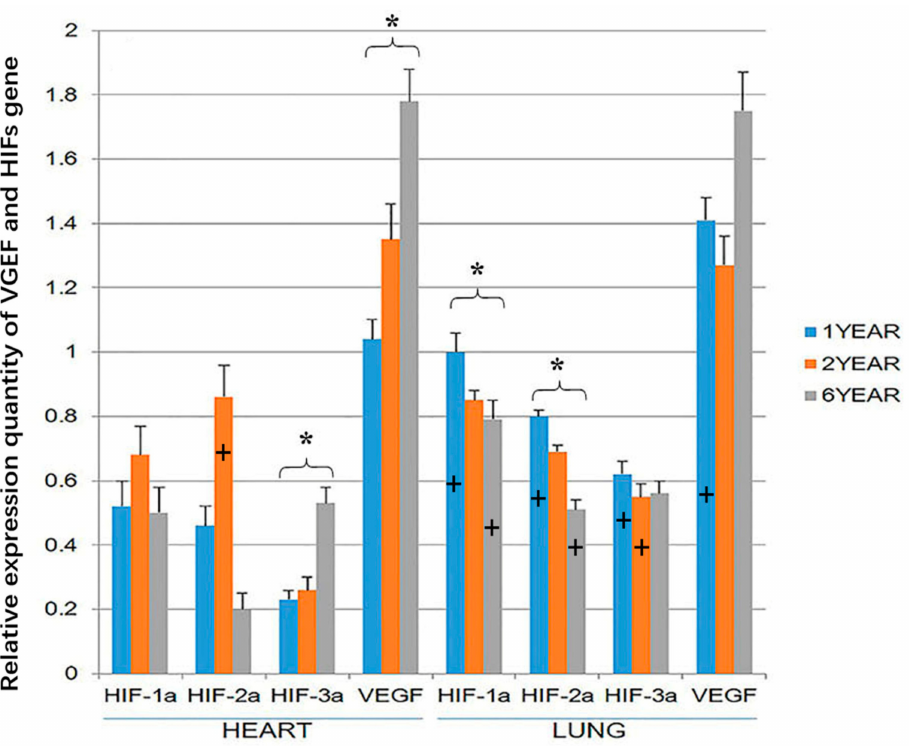
Figure 5. Hypoxia-inducible factor (HIF)-1 α , HIF-2 α , HIF-3 α and vascular endothelial growth factor (VEGF) gene expression in the heart and lung of Tibetan sheep were measured by RTPCR (Reverse transcription polymerase chain reaction). Values are means ± SD ( n = 10). * indicates a significant di ff erence ( p < 0.05) in gene expression within a tissue between 1-year-old and 6-year-old sheep. + indicates a significant di ff erence ( p < 0.05) between gene expression in the heart and the expression of the same gene at the same age in the lung. The bar containing + has the significantly higher gene